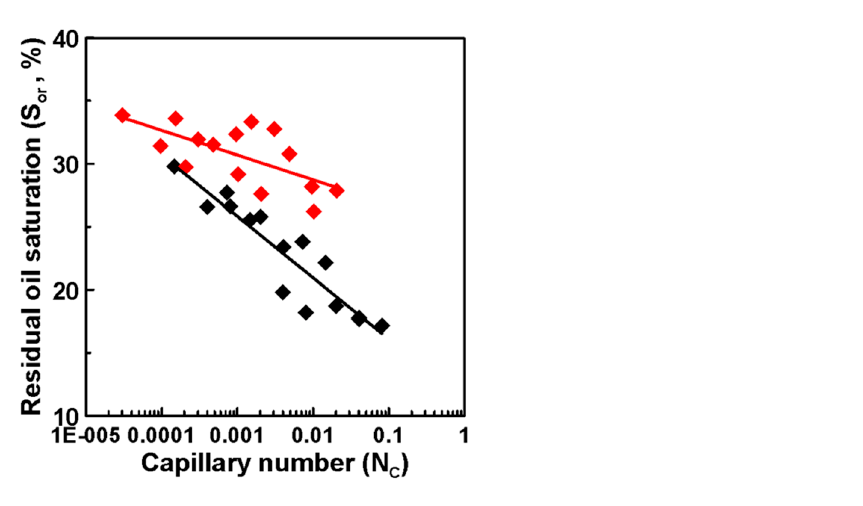
Figure 10. Residual oil saturation as a function of capillary number in the presence or absence of a zwitterionic surfactant (red: no surfactant; black: with